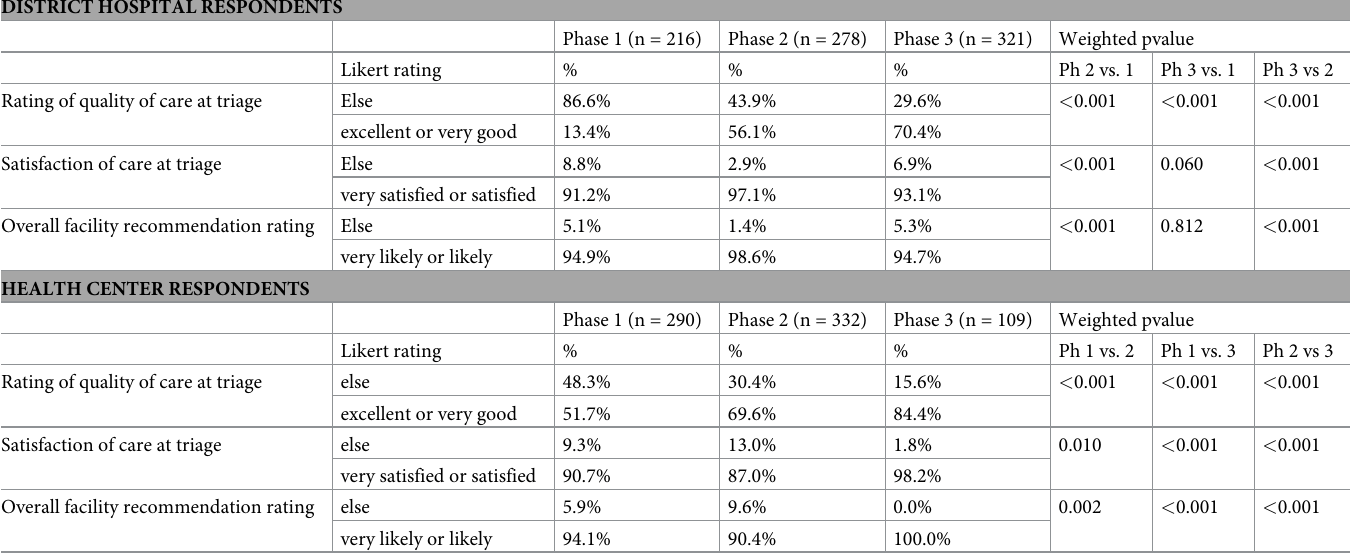
Table 3. Women’s perceptions of care �